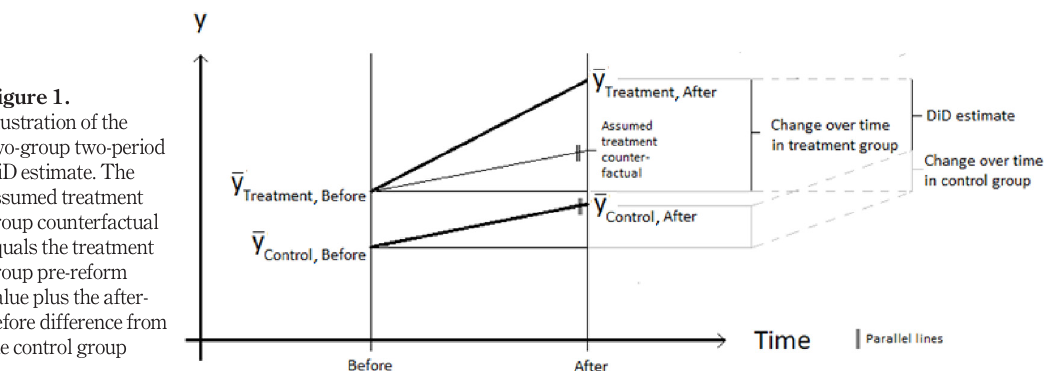
Figure 1. Illustration of the two-group two-period DiD estimate. The assumed treatment group counterfactual equals the treatment group pre-reform value plus the after- before difference from the control